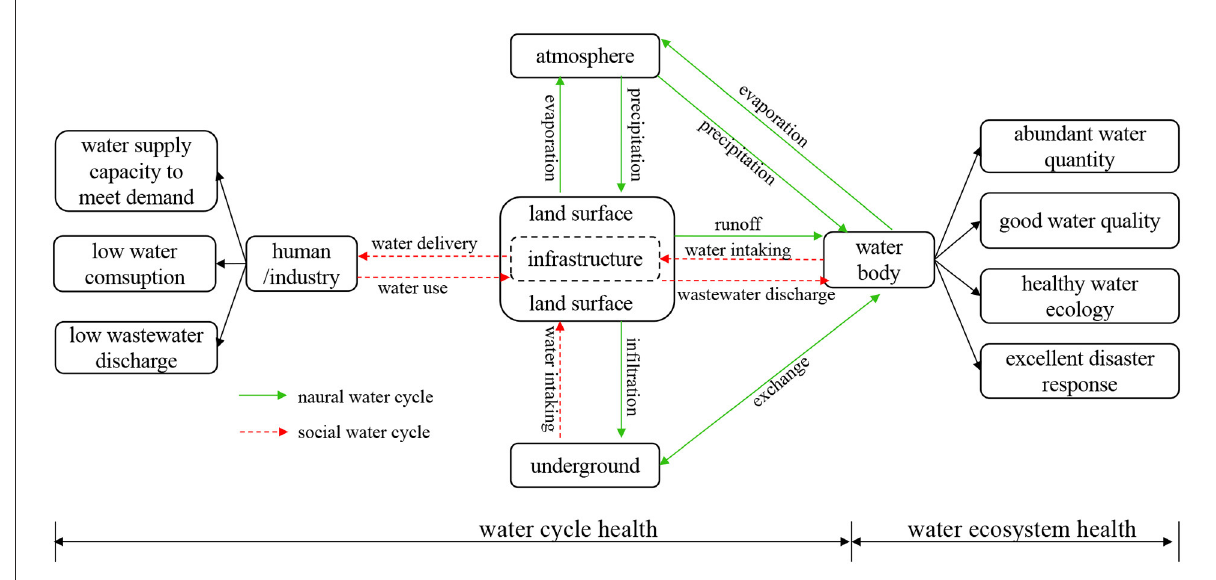
FIGURE2 A conceptual framework of urban water health (UWH; Zhang and Xiong, 2006; Yang et al.,